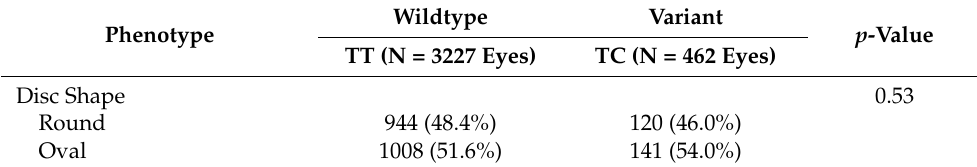
Table 2. Association of TRIM66 rs112369934 in qualitative POAG phenotypes 1